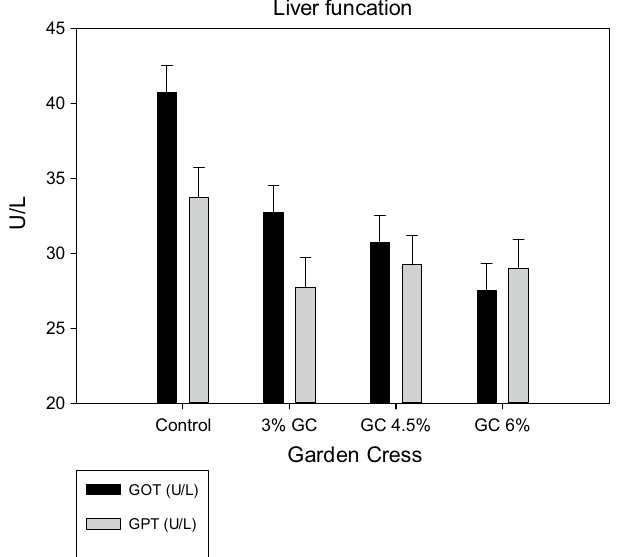
Figure 3. Effect of dietary levels of garden cress seeds on serum liver function of doe rabbits.